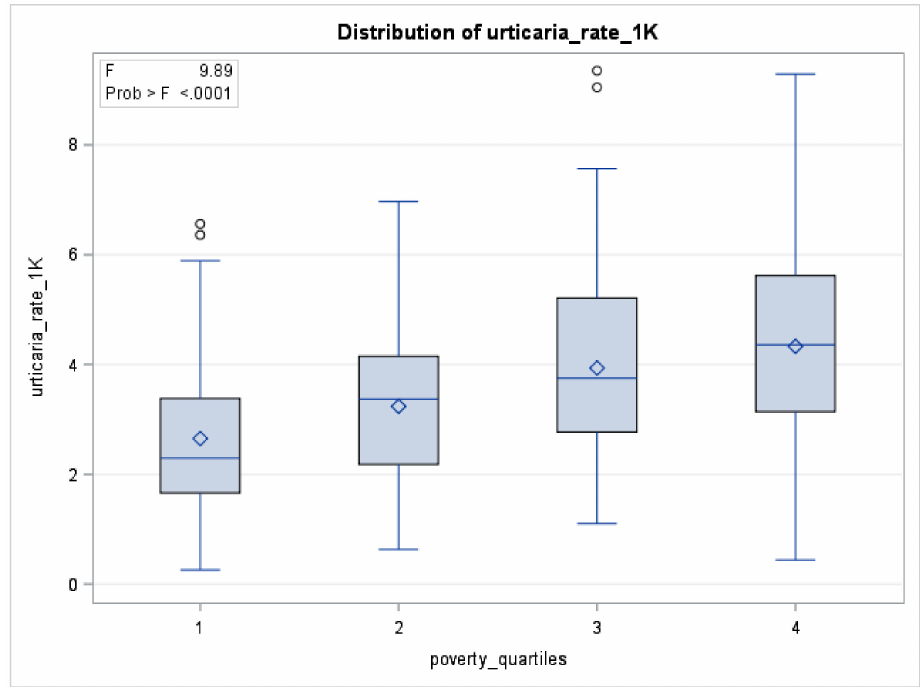
Figure 1. Distribution of acute urticaria rate per 1000 residents by poverty quartiles for selected zip codes ( n = 201), San Joaquin Valley, 2016–2017. Boxplots for percentage of poverty quartiles 1–4 are shown (F <